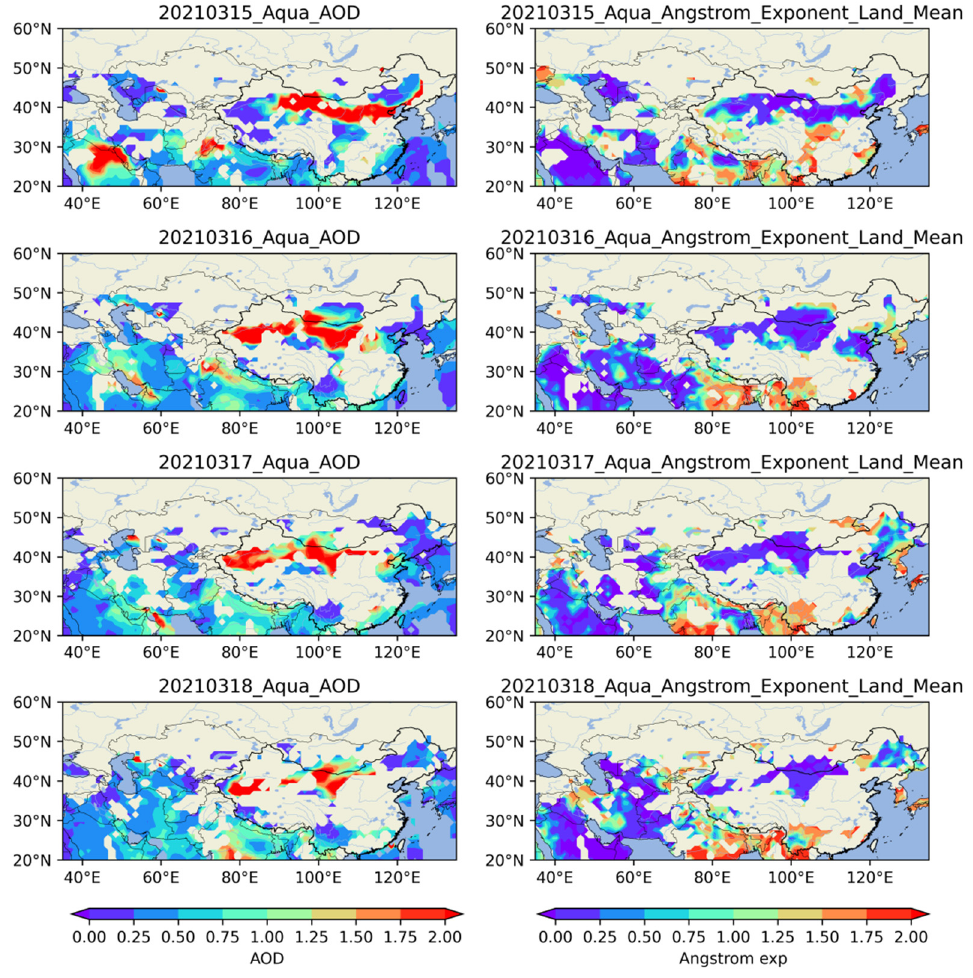
Figure 8. The evolution of Aqua-MODIS AOD and AE from 15 March to 18 March.